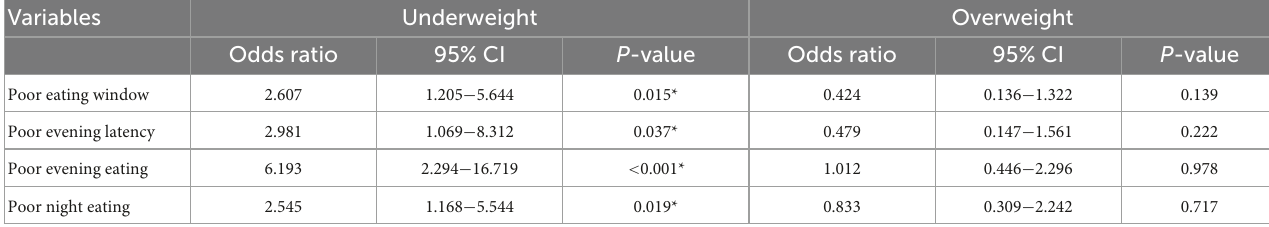
Normal weight Overweight Total ( n = 409) ( n = 101) ( n = 202) ( n = 106)